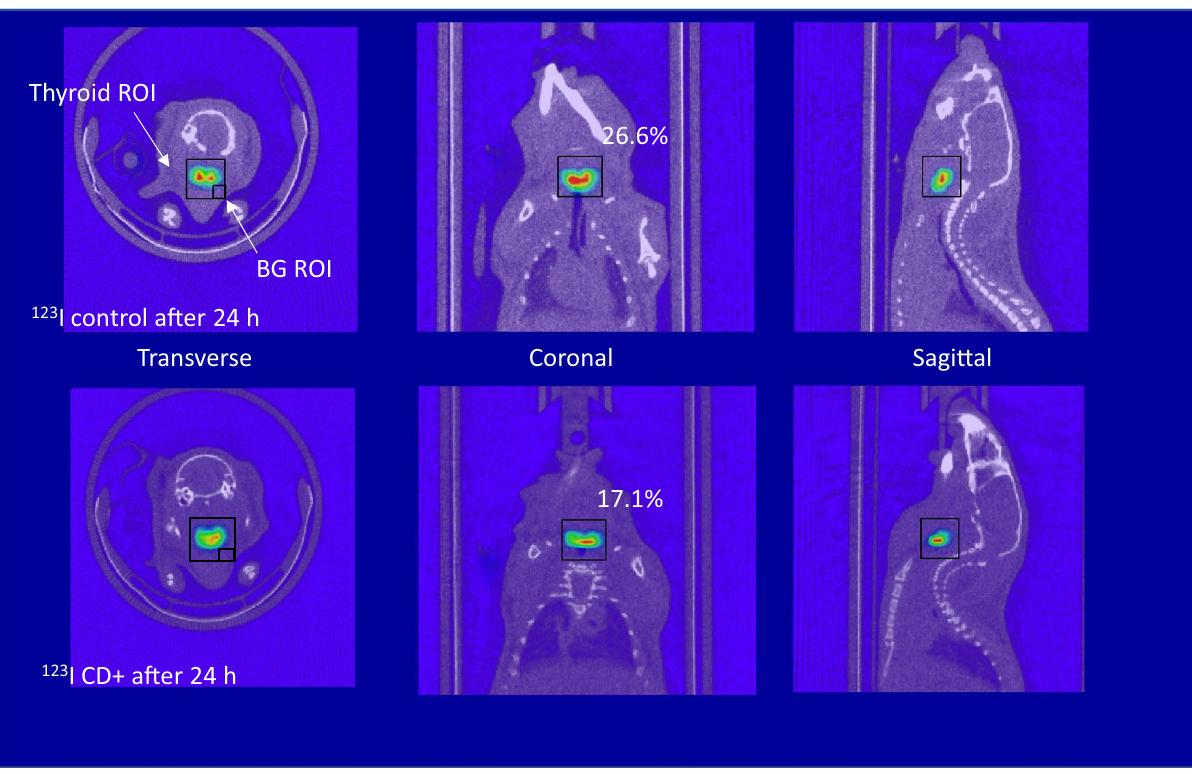
Figure 2. The 24-h thyroid single-photon emission computed tomography (SPECT) images of Na 123 I and α-CD administered mice, and control mice with normal thyroid function (with α-CD solution replaced with saline).